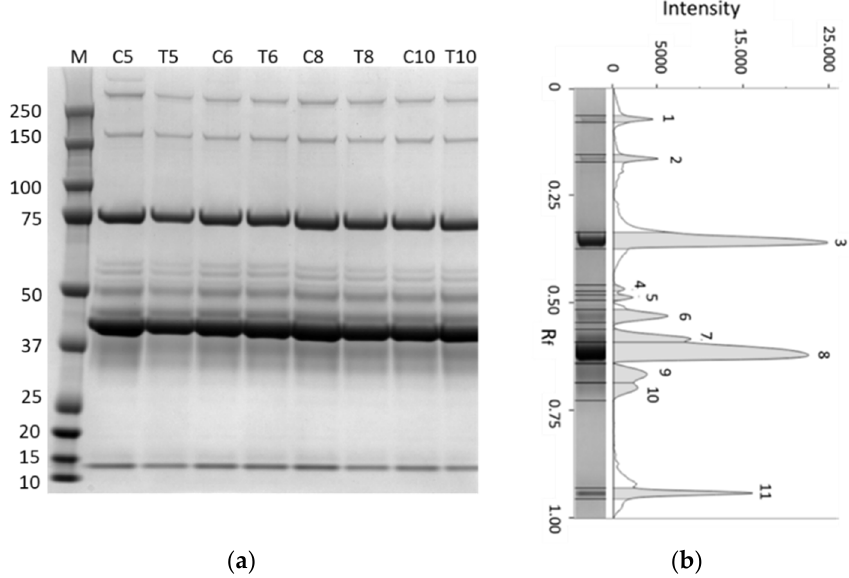
Figure 5. Representative gel and pherogram of egg albumen proteins separated using SDS–PAGE 4–12%: ( a ) lane 1: molecular mass marker (kD); lanes 2, 4, 6, and 8: albumens from control hens at 5th, 6th, 8th and 10th week (C5–C10); lanes 3, 5, 7, and 9: albumens from supplemented hens at 5th, 6th, 8th, and 10th week (T5–T10); ( b ) the pherogram obtained from lane 3 is reported as an example (right).